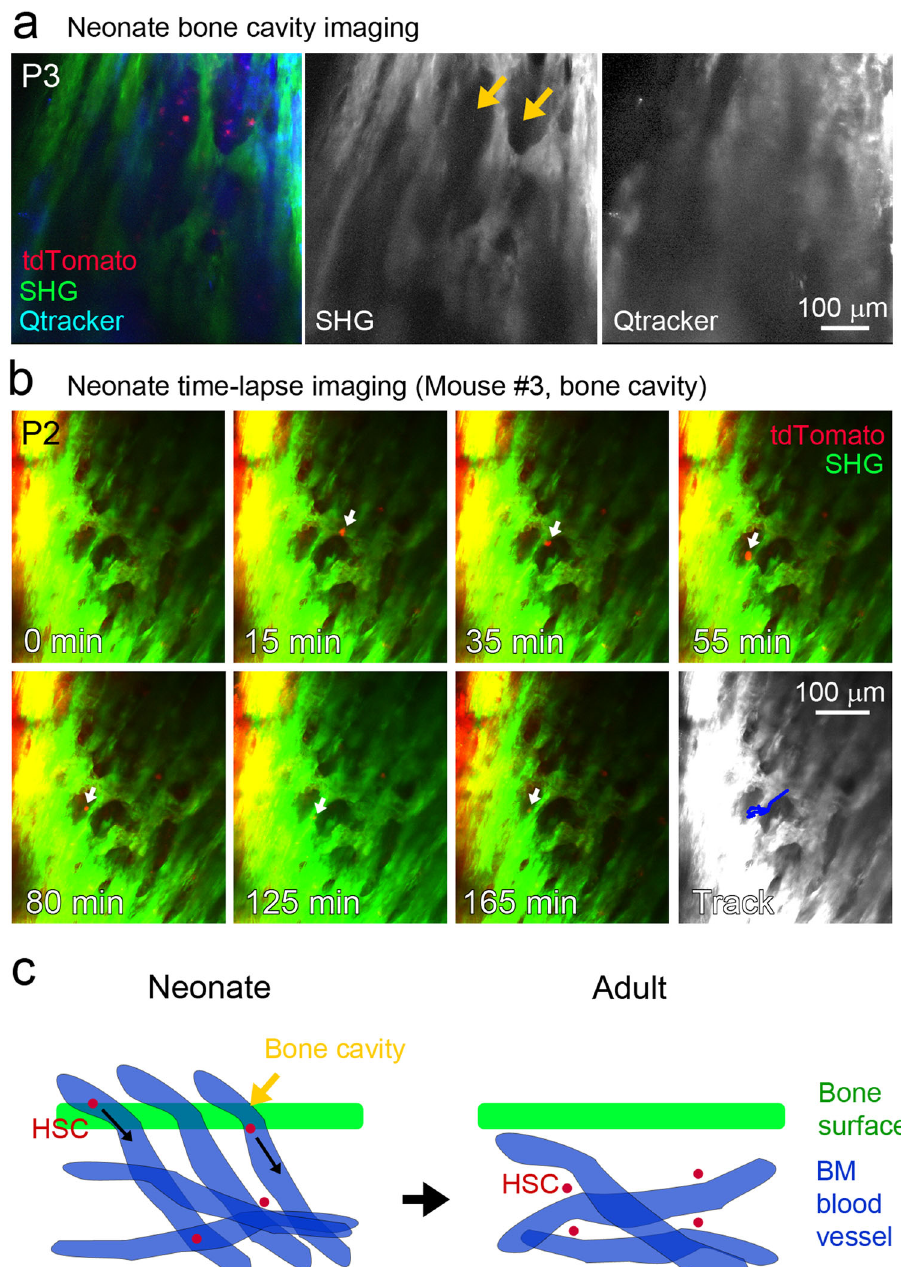
Fig. 6 Intravital time-lapse imaging of Hlf-tdTomato-labeled cells in the bone cavity of the neonatal tibia. a Two-photon images showing the blood vessels penetrating the bone cavity in the tibial bone in a neonatal mouse (P3). Yellow arrows indicate bone cavities. b Time-lapse images of Hlf- tdTomato hi cells migrating from the bone surface to the bone marrow cavity. White arrows indicate a migrating cell in the bone cavity. See also Supplementary Movie 6. c “ Transient vessel penetration model ” for HSC homing during bone marrow formation. HSCs migrate from outside the tibia to inside via transient blood vessels penetrating the bone during bone marrow Methods Animals . Hlf-tdTomato KI mice were generated in the previously study 25 . Runx1- GFP mice were kindly provided by M. Osato (Cancer Science Institute of Singa- pore, National University of Singapore) 29 . C57BL/6-Ly5.1 mice were used for competitive bone marrow transplantation experiments. Data were taken from distinct mice or cells unless otherwise noted. All animal experiments were conducted according to the guidelines of Kumamoto University on animal use. Flow cytometry . For fl ow cytometric analysis, bone marrow cells were prepared by crushing the bones using a mortar and pestle 25 . Antibodies against CD45 (30-F11,